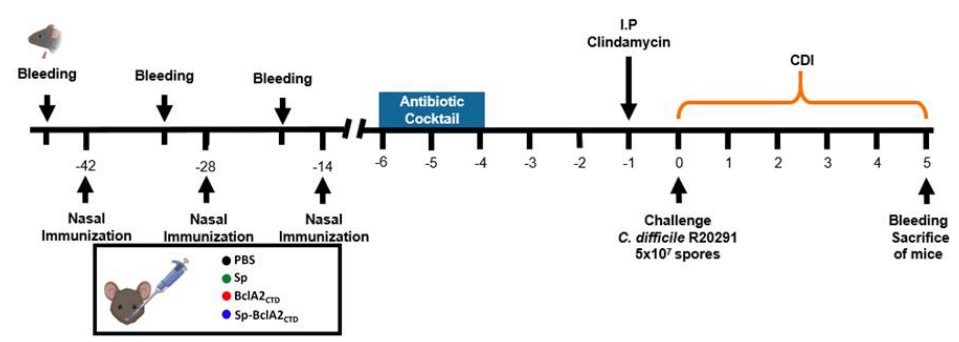
Figure 6. Overview of the experimental design schematics for the prevention of C. difficile infection in a murine model. C57BL/6 mice were nasally immunized 3 times (42, 28, and 14 d before challenge with C. difficile R20291 spores) with PBS, spores of B. subtilis PY79 (Sp), pure BclA2 CTD , or spores of B. subtilis adsorbed with BclA2 CTD (Sp-BclA2 CTD ). Prior to the infection, the animals were submitted to an antibiotic cocktail (4 to 6 d before challenge) and clindamycin administration (1 d before challenge). On day 0 mice were infected with 5 x 10 7 spores of C. difficile R20291 and were monitored for C. difficile infection (CDI) symptoms from day 0 to day 5. Serum was collected one day before each immunization as well as on the day of sacrifice (days 0, 13, 27, and 47).